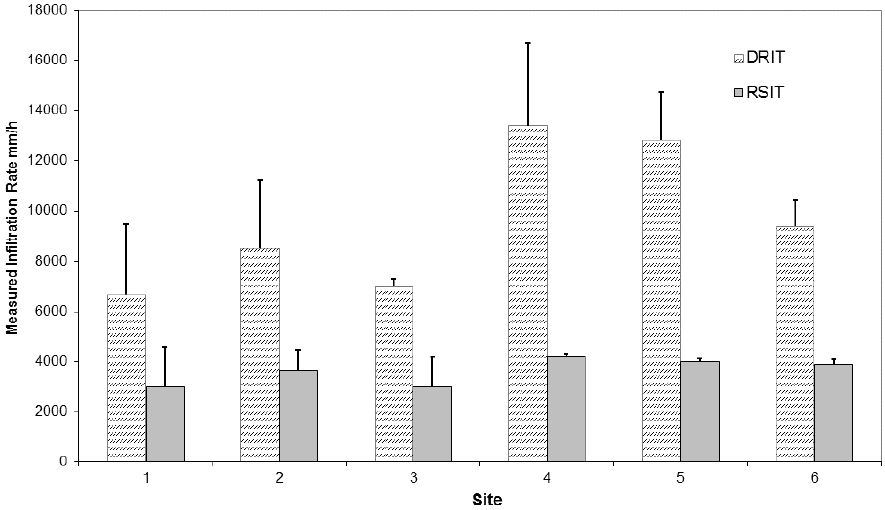
Figure 6. Comparison of average PICP infiltration rates obtained using the double-ring infiltrometer (DRIT) and rainfall simulation infiltrometer (RSIT)